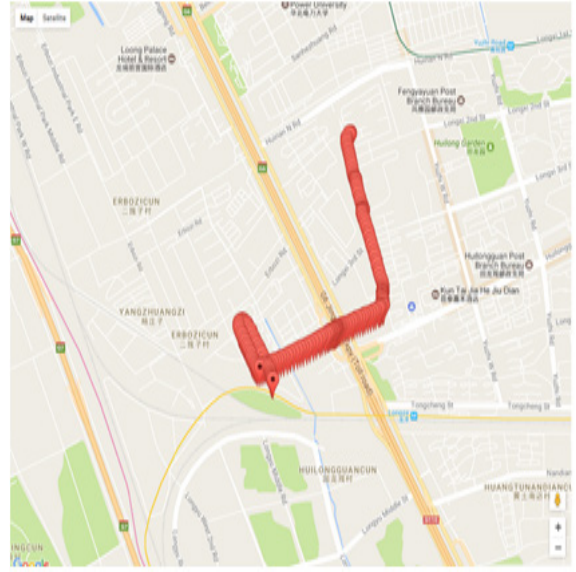
Fig. 1. The original trajectory.